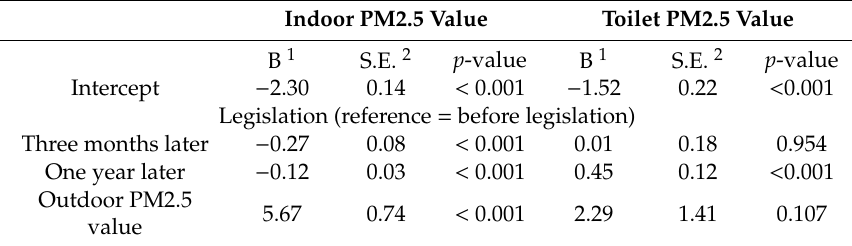
Figure 1. Description of PM2.5 value. Table 5. Change of PM2.5 value after adjusting for outdoor background value.